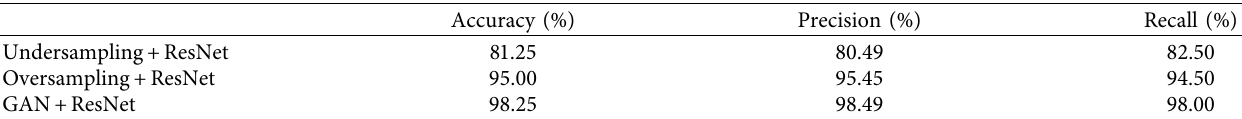
Table 10: Classification result